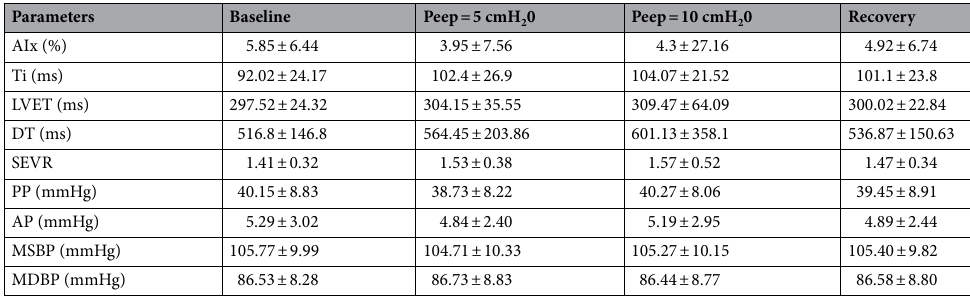
Table 2. CWA parameters of the population in study. Data are expressed as mean ± standard deviation (SD). PEEP, Positive end-expiratory pressure; AIx, augmentation index; Ti, time to inflection point; LVET, Left Ventricular Ejection Time; DT, Diastolic time; SEVR, diastolic AUC divided by systolic-AUC (Buckberg index); PP, Pulse pressure; AP, Augmentation pressure; MSBP, Mean systolic blood pressure; MDBP, Mean diastolic blood pressure; ms: milliseconds.